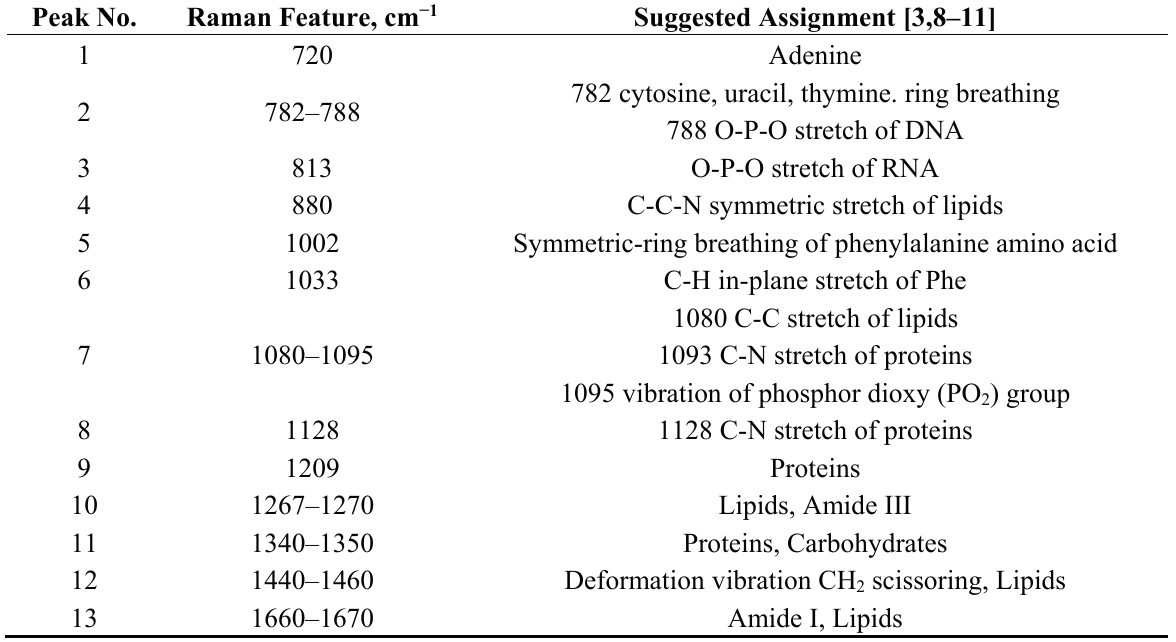
Table 1. Summary of prominent peaks/bands observed in the Raman spectra of yeast, together with suggested assignments of chemical compounds. The peak numbers of the table are used to identify features in the spectra shown at Figure 2. Peak No.